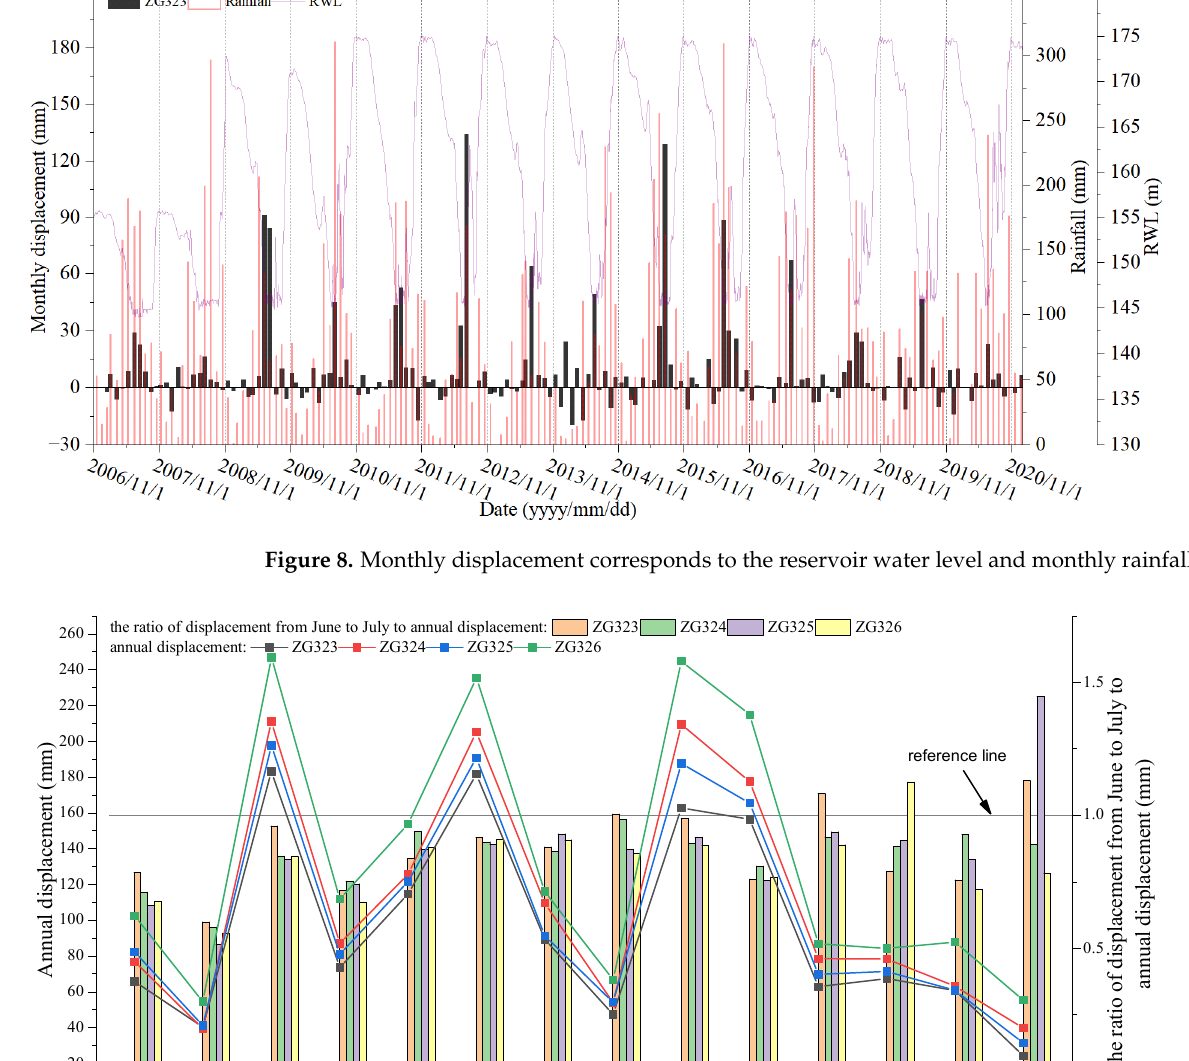
Figure 7. Time series of monitoring accumulative displacement, reservoir water level, and month- ly rainfall.